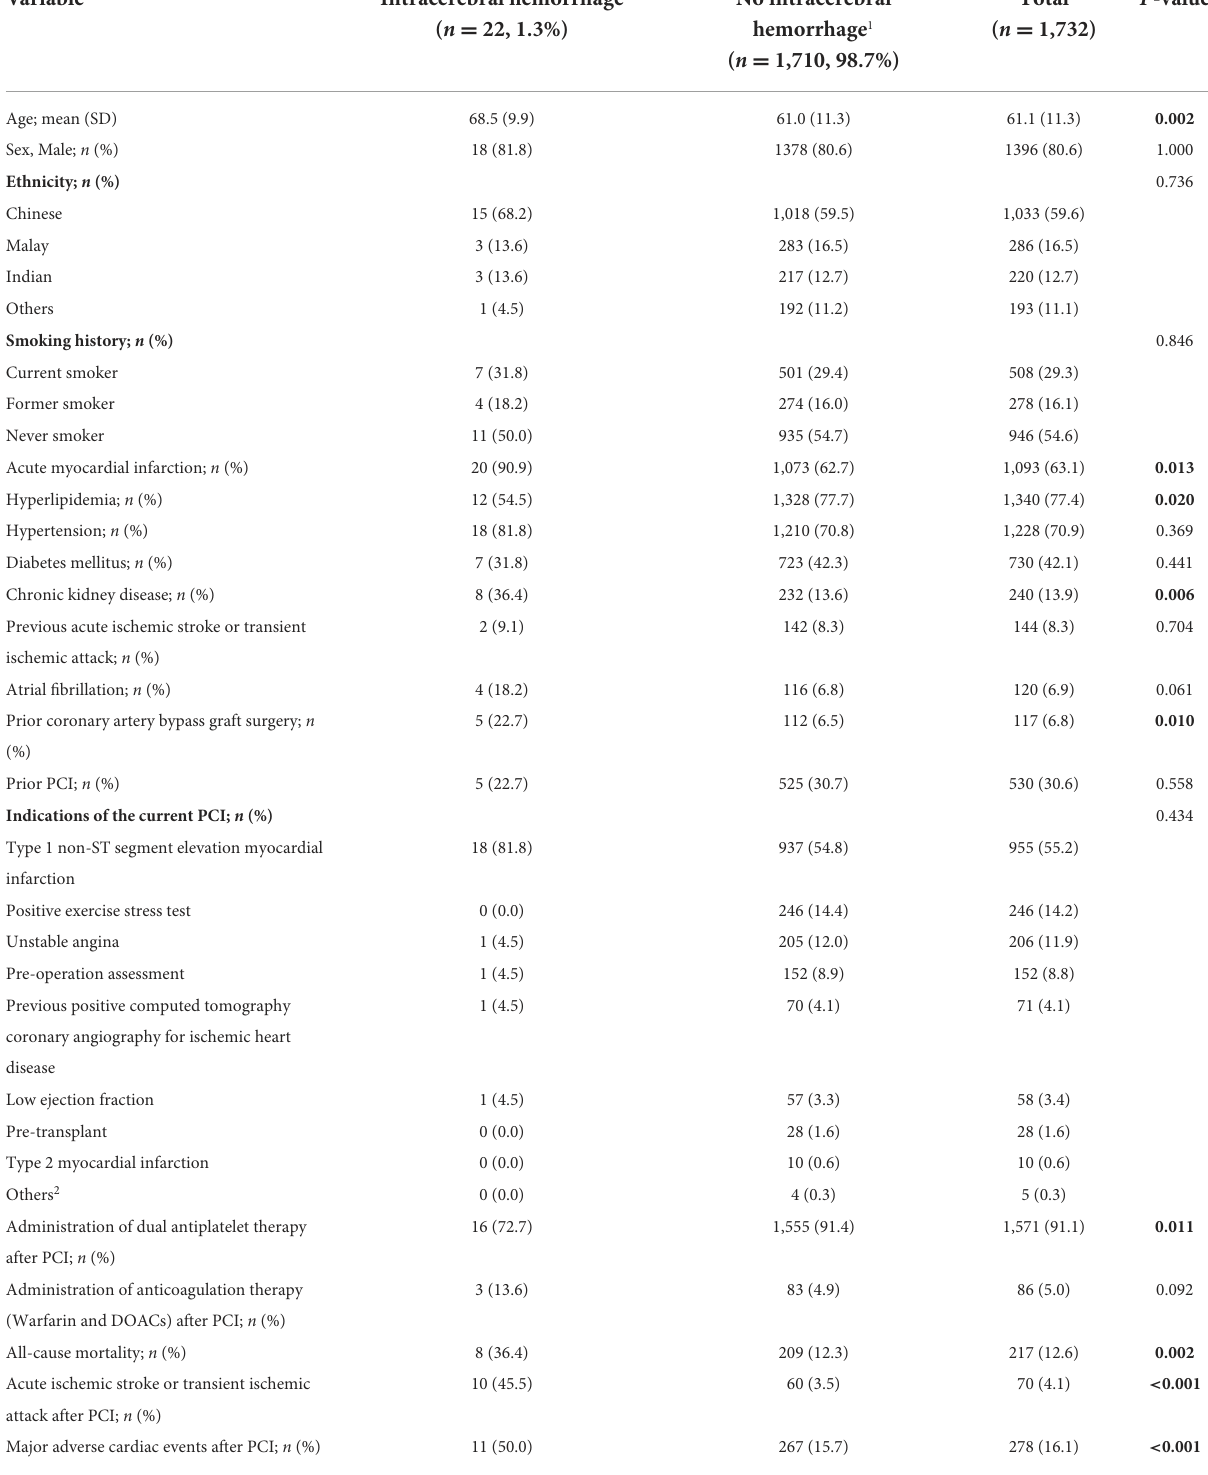
TABLE 1 Baseline characteristics of patients with and without intracerebral hemorrhage after non-emergency percutaneous coronary intervention.